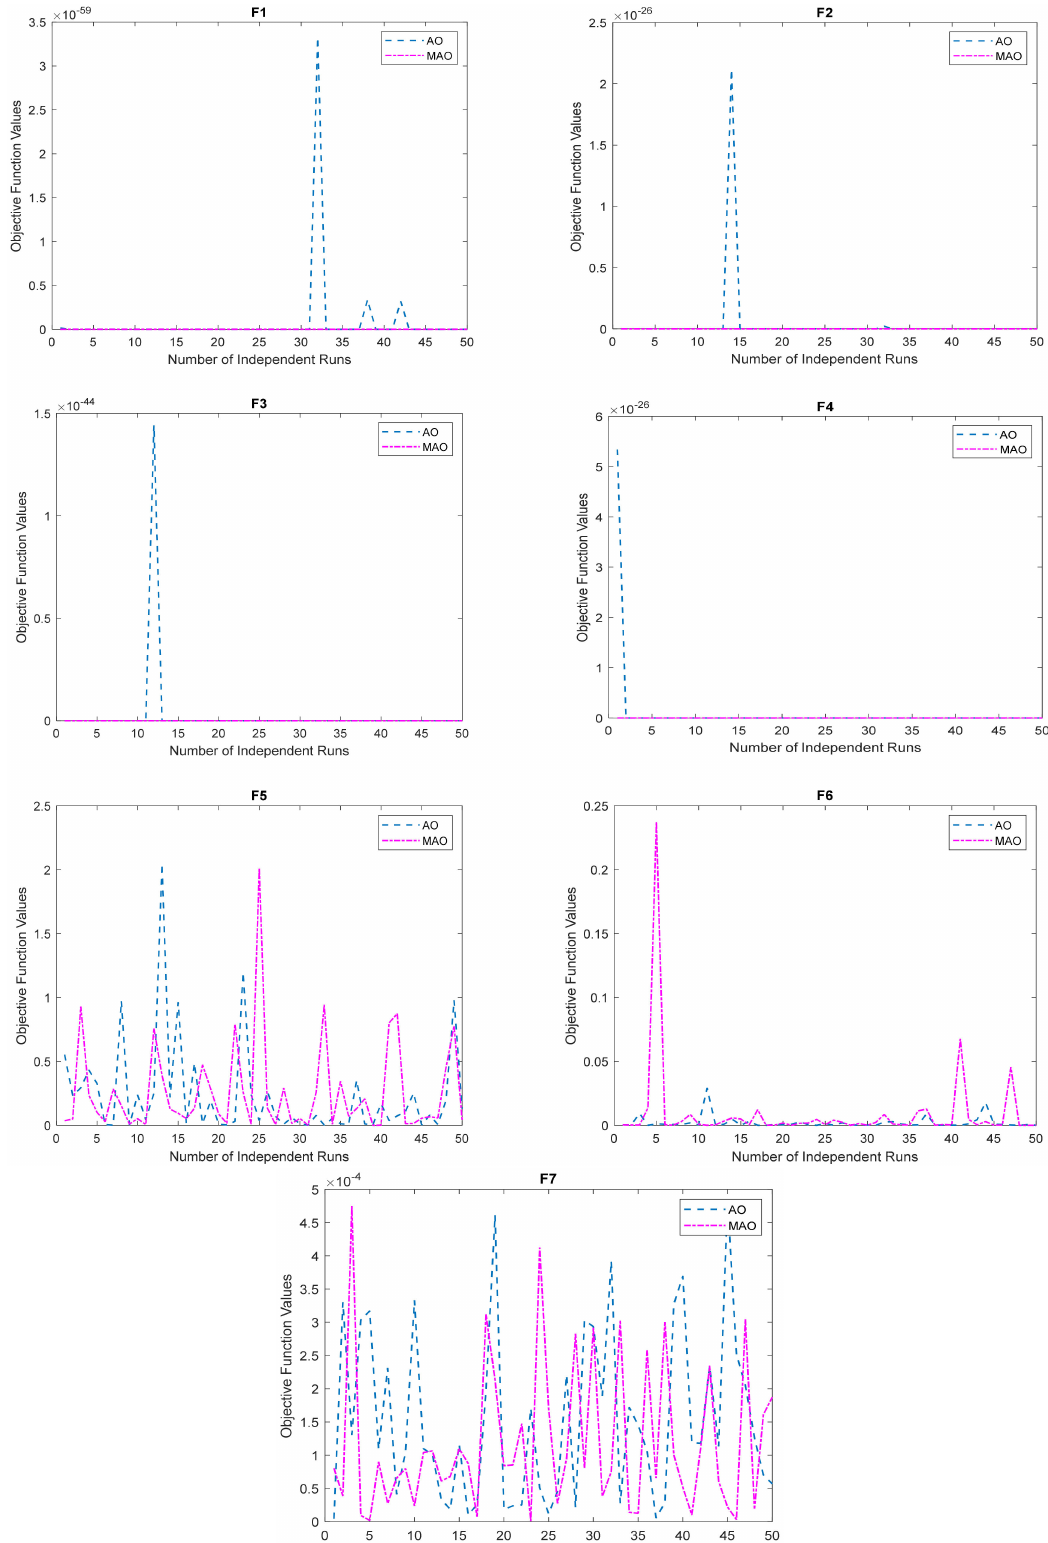
Figure 8. Independent runs of unimodal benchmark functions with D =